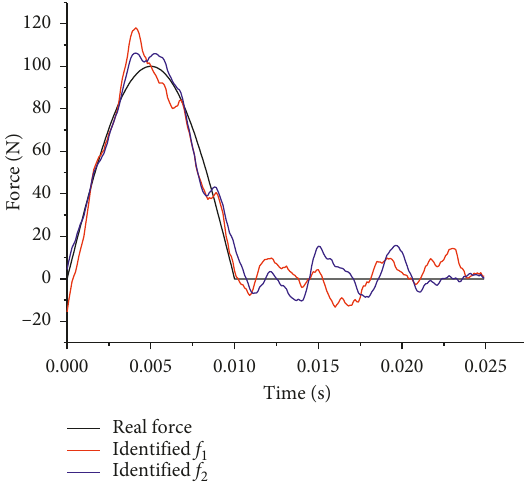
Figure 8: Real load history and identified loads of F